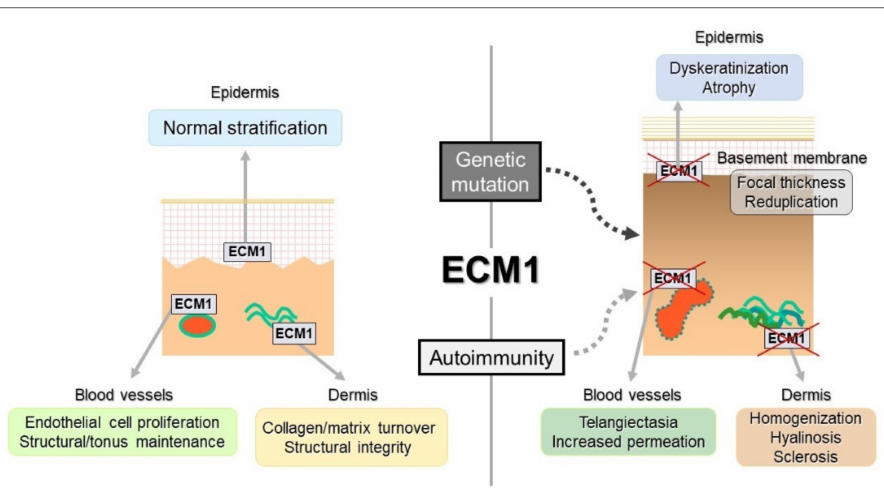
Figure 5. Schematic image for autoimmune and genetic impairment of ECM1 function in the skin. Genetic ablation and autoantibody targeting of the skin ECM1 cause dysregulation of its binding partners, as listed in Figure 3, contributing to the homeostatic imbalance or collapse in the epidermis (dyskeratosis and atrophy), dermis (collagen homogenization and sclerosis), and blood vessels (telangiectasia and impermeability). The chain of these statements finally establishes the pathological features seen in LiP and